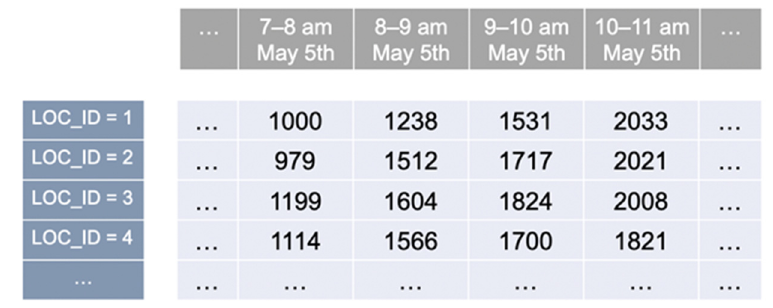
Figure 1. Input block of longitudinally stacked locations’ time series. Each value refers to the number of recorded vehicles crossing a certain location within a defined time span.